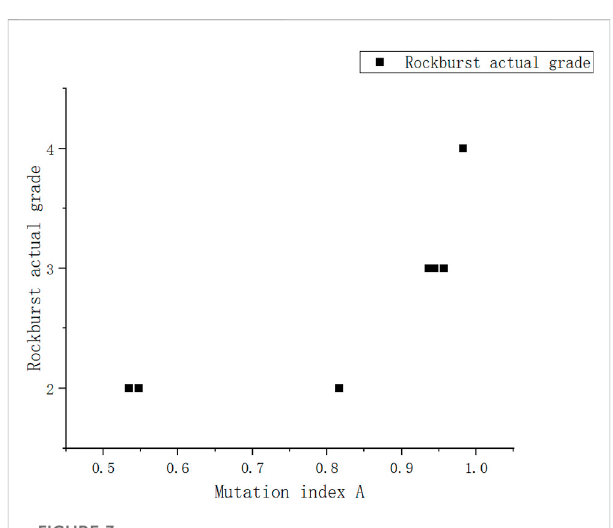
FIGURE 3 Mutation value and rockburst level